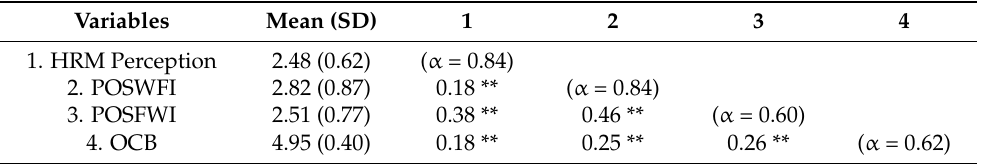
Table 1. Descriptive statistics and correlations (* p < 0.05. ** p <